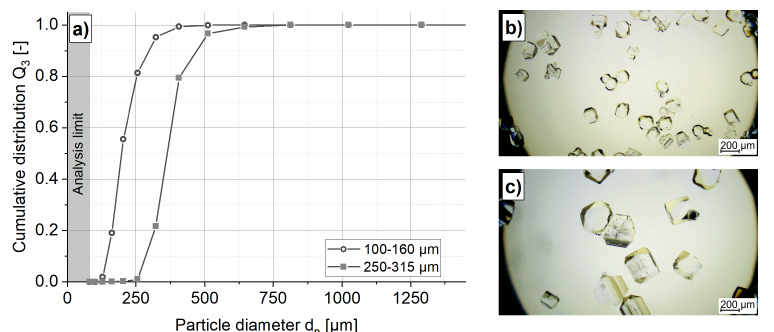
Figure 2. Seed crystal properties described by ( a ) particle size distributions Q 3 and microscopic images of ( b ) sieve fraction 100–160 µ m with mode d mod = 182 µ m, and ( c ) sieve fraction 250–315 µ m with mode d mod = 364 µ m.